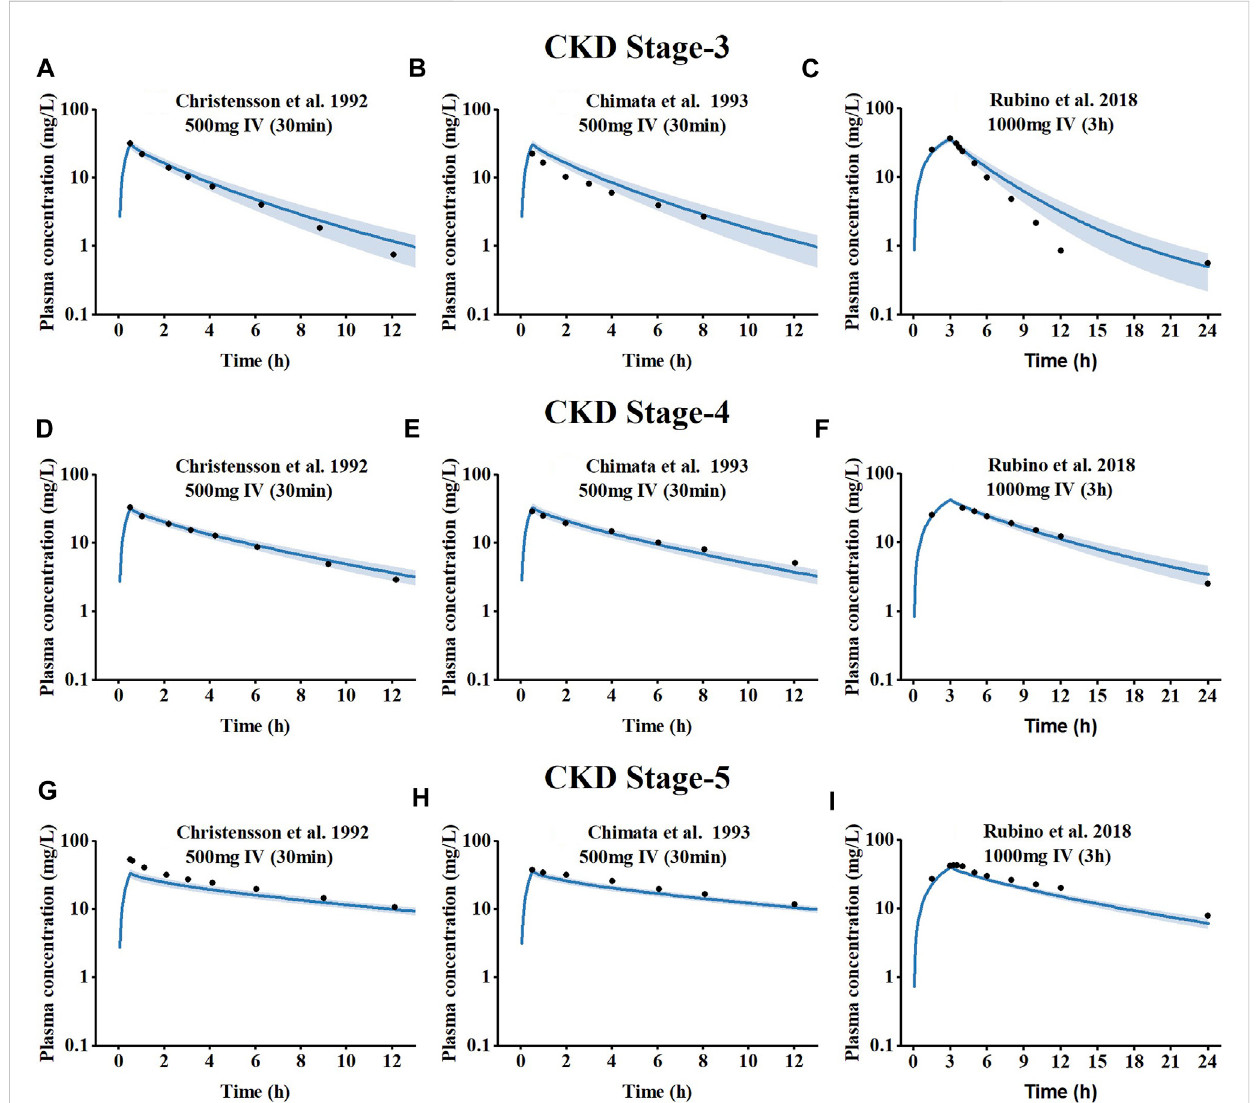
FIGURE 3 Simulated plasma concentration-time pro fi les for meropenem at different CKD stages, compared to observed data. (A – C) CKD stage 3, (D – F) CKD stage4,and (G – I) CKDstage5.Theshadedareaindicatesthecorrespondingstandarddeviation(SD)forthesimulateddata,andtheblackcirclesrepresent the mean observed concentration for each respective